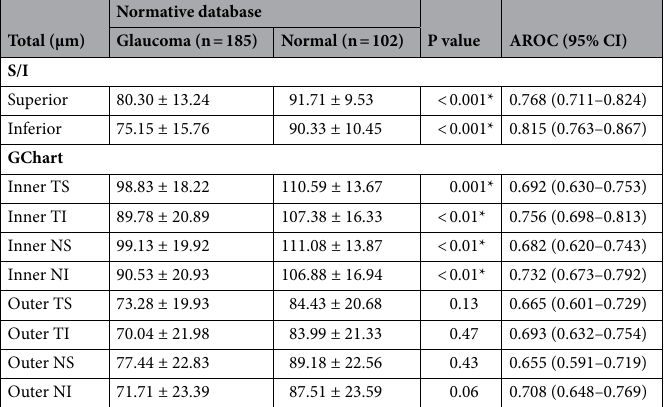
Table 3. Comparison of the analysis chart parameters of mGCC thickness between highly myopic glaucoma group and highly myopic normal group (REGULAR database). AROC Covariate-Adjusted Receiver Operating Characteristic, CI Confidence Interval, S/I Superior/Inferior, TS Temporal-Superior, TI Temporal-Inferior, NS Nasal-Superior, NI Nasal-Inferior. *Statistical significance shown at p < 0.05.